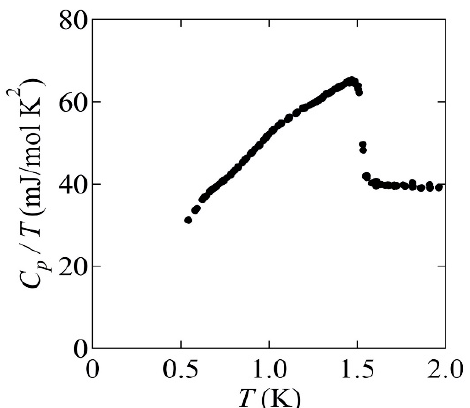
Figure 7. Specific heat divided by temperature ( C P /T ) as a function of temperature below 2 K. A clear transition at 1.5 K is seen. Additionally, the residual density of states is small when C P /T extrapolates to zero Kelvin.